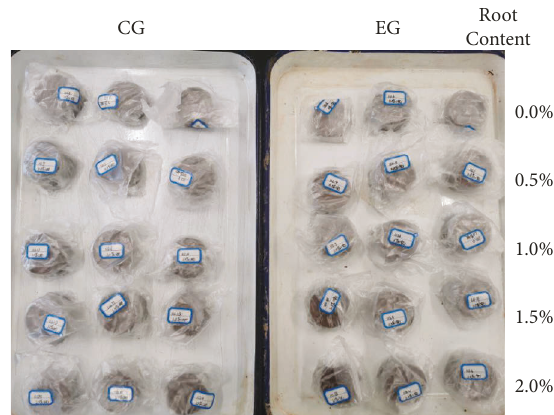
Figure 3: Root-soil composite